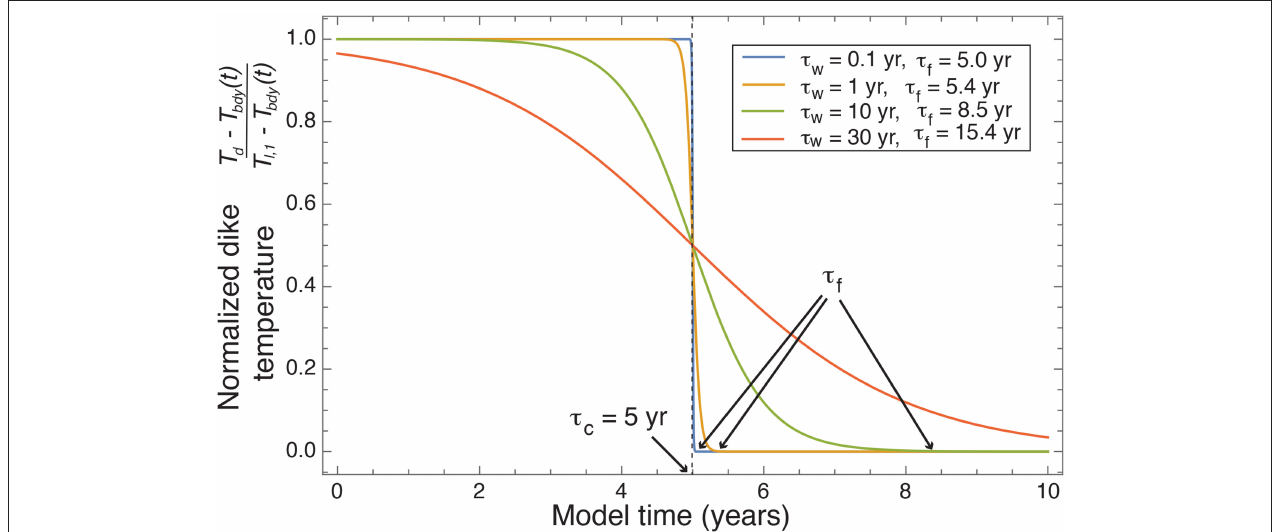
FIGURE 5 | Normalized dike temperature from Equation (11), illustrating trade-offs between the scale for dike active flow τ c and the scale for flow unsteadiness τ w . τ f is the total duration of temperatures elevated over background, and may be similar to τ c for small τ w . Equation (11) is enforced in our model for dike contact temperatures T d > T bdy ( t ) and times t < τ f .